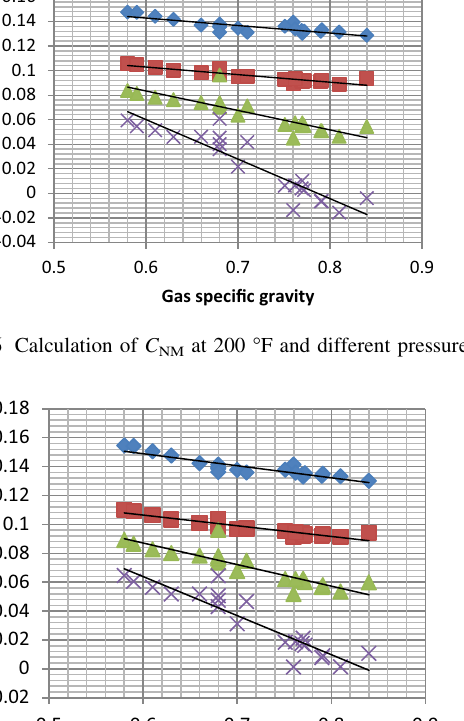
Fig. 8 Calculation of C NM at 240 (cid:3) F and different pressures